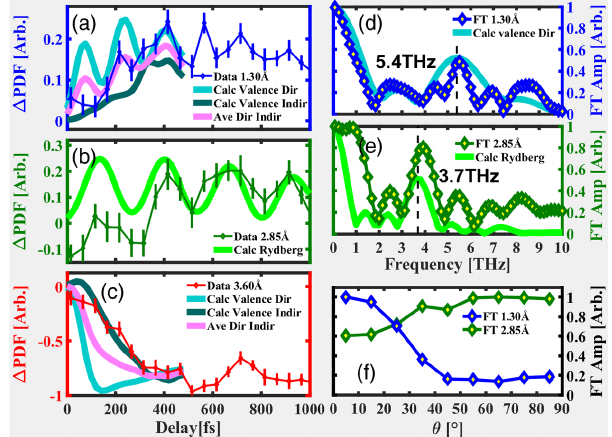
FIG. 4. Time-resolved Δ PDF at specific pair distances and their Fourier transforms for both experiment and simulation. (a) Ex- perimental and simulated time-resolved Δ PDF around 1.30 Å. The simulated Δ PDF are calculated from the groups of both direct (Dir) and indirect (InDir) dissociative trajectories. (b) Ex- perimental and simulated time-resolved Δ PDF around2.85 Å. The simulation is from the group of Rydberg state trajectories. (c) Experimental and simulated time-resolved Δ PDF around 3.60 Å. The simulations are from both direct and indirect dissociative trajectories. The pink curves in panels (a) and (c) are for an equally weighted average of direct and indirect trajectories. Appendix B 4 contains a comparison of the data and simulation with different mixtures of direct and indirect trajectories. (d) Fourier analysis of Δ PDF at 1.30 Å from experimental data and simulation of direct dissociation trajectories [panel (a)] for a polar angle of 0°. (e) Fourier analysis of Δ PDF at 2.85 Å from experimental data and Rydberg state trajectories [panel (b)] for a polar angle of 70°. (f) Angle-dependent Fourier analysis of the Δ PDF at 1.30 Å and 2.85 Å. Note that θ is the angle with respect to the laser polarization